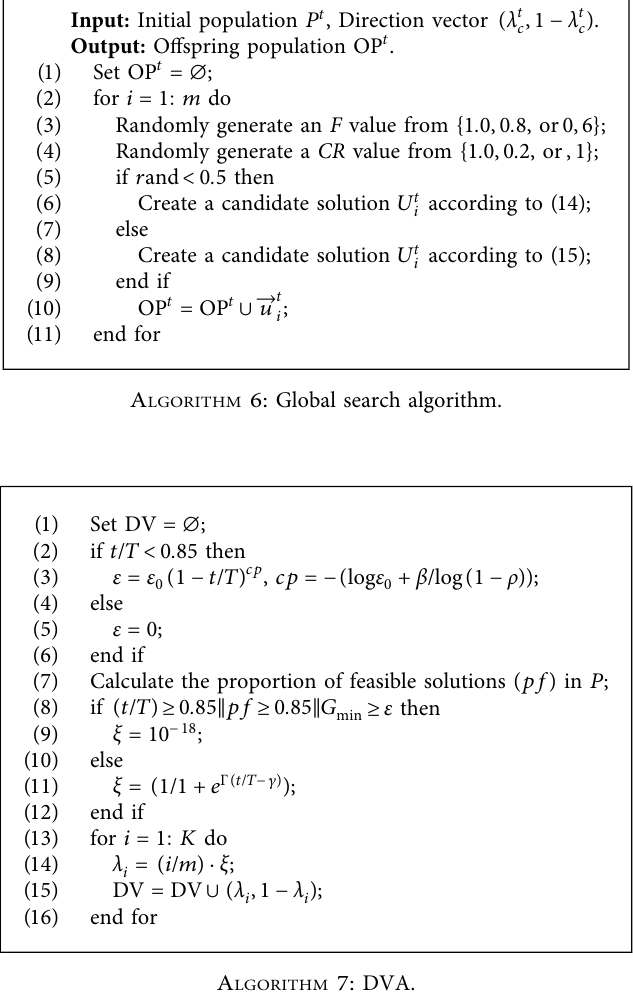
Table 1: The population size m , the number of subpopulations K , and the total number of function evaluations T_FEs . Test functions T_FEs m K 18 COPs ( d � 10) from CEC 2010 2.0 E +05 80 14 18 COPs ( d � 30) from CEC 2010 6.0 E +05 100 15 28 COPs ( d � 50) from CEC 2017 28 COPs ( d � 100) from CEC